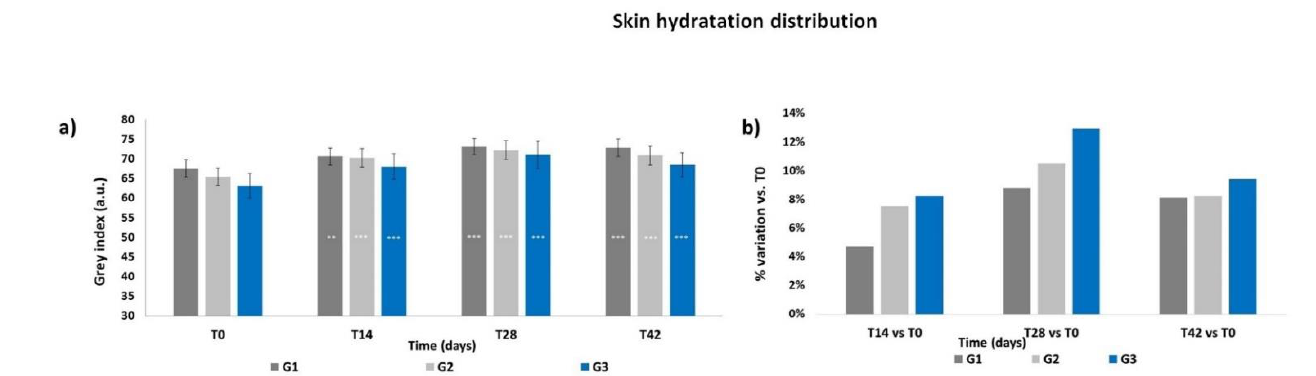
Figure 2. Skin hydration distribution. The graphs show data obtained at each monitored time for the three groups. ( a ) Data are expressed in Grey Index arbitrary units (mean ± SEM). ( b ) Data are reported as mean percentage variation with respect to T0. Legend = *** p < 0.001 vs. T0, ** p < 0.01 vs. T0.